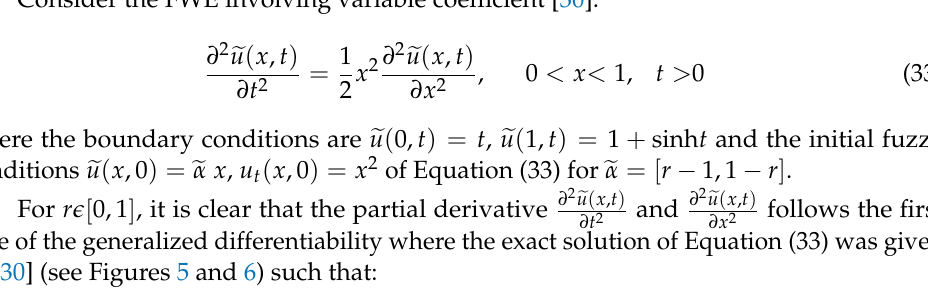
Figure 4. The exact and numerical solution of Equation (31) by implicit at t = 0.5 and x = 0.9 for all r , β ∈ [ 0,1 ] .